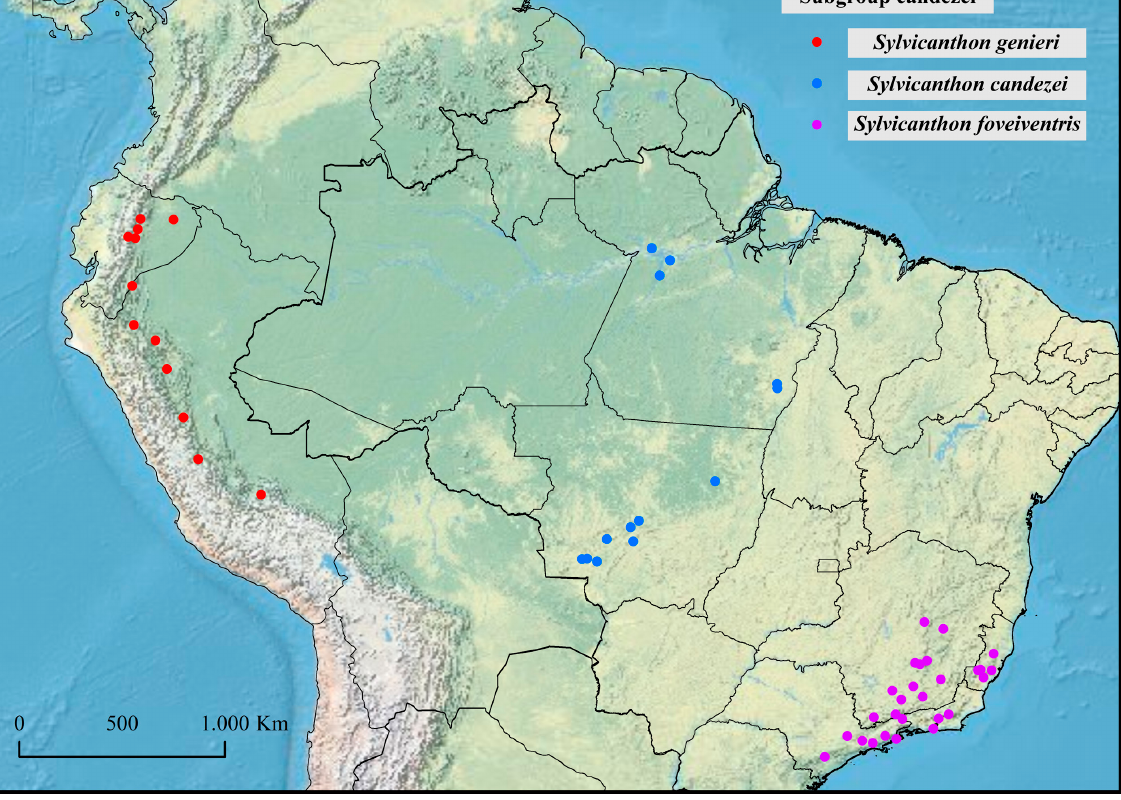
Fig. 24. Distribution of the three species of the candezei